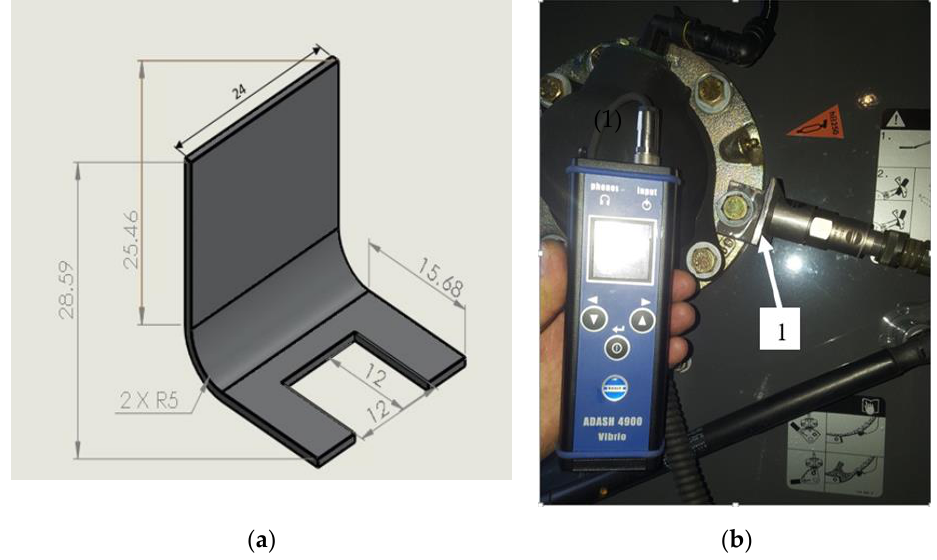
Figure 2. Manufactured bracket for vibration measuring points that are difficult to access: ( a ) dimension of the bracket; ( b ) accelerometer placed on the bracket (1).